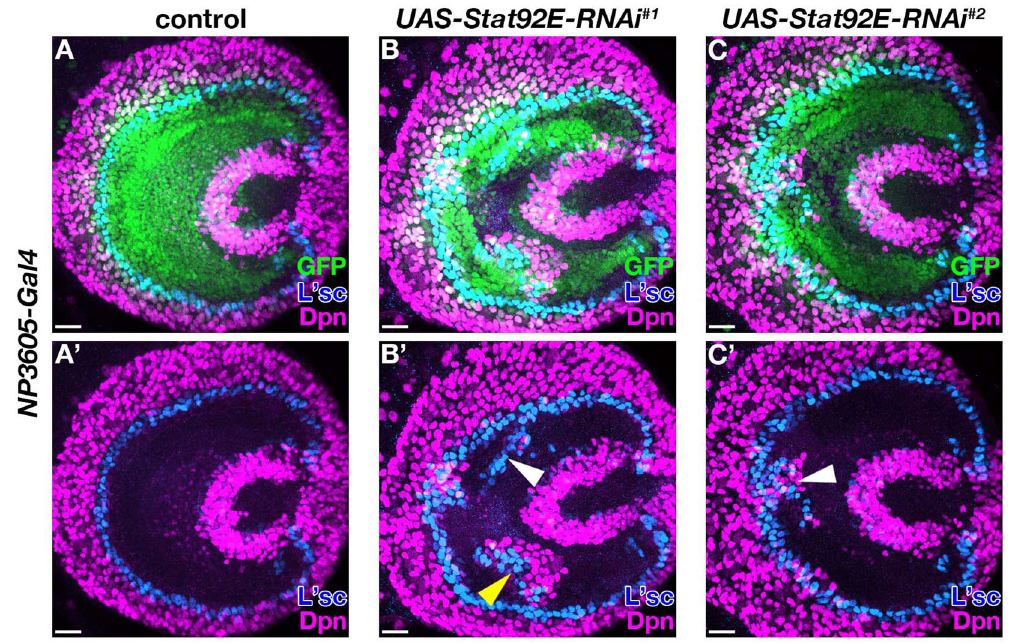
Figure 4. Stat92E blocks spontaneous neuroblast differentiation in vivo . ( A – C’ ) Third-instar larval optic lobes for control ( A ), UAS-Stat92E-RNAi #1 ( B ), and UAS-Stat92E-RNAi #2 ( C ). NP3605-Gal4 UAS-GFP . nls (green), L’sc (blue) and Dpn (magenta) are shown. ( A’ – C’ ) L’sc and Dpn are shown. White arrowheads in ( B’ , C’ ) indicate ectopic L’sc and Dpn expression. The yellow arrowhead indicates ectopic L’sc expression medial to ectopic Dpn expression. Scale bars, 20 μ